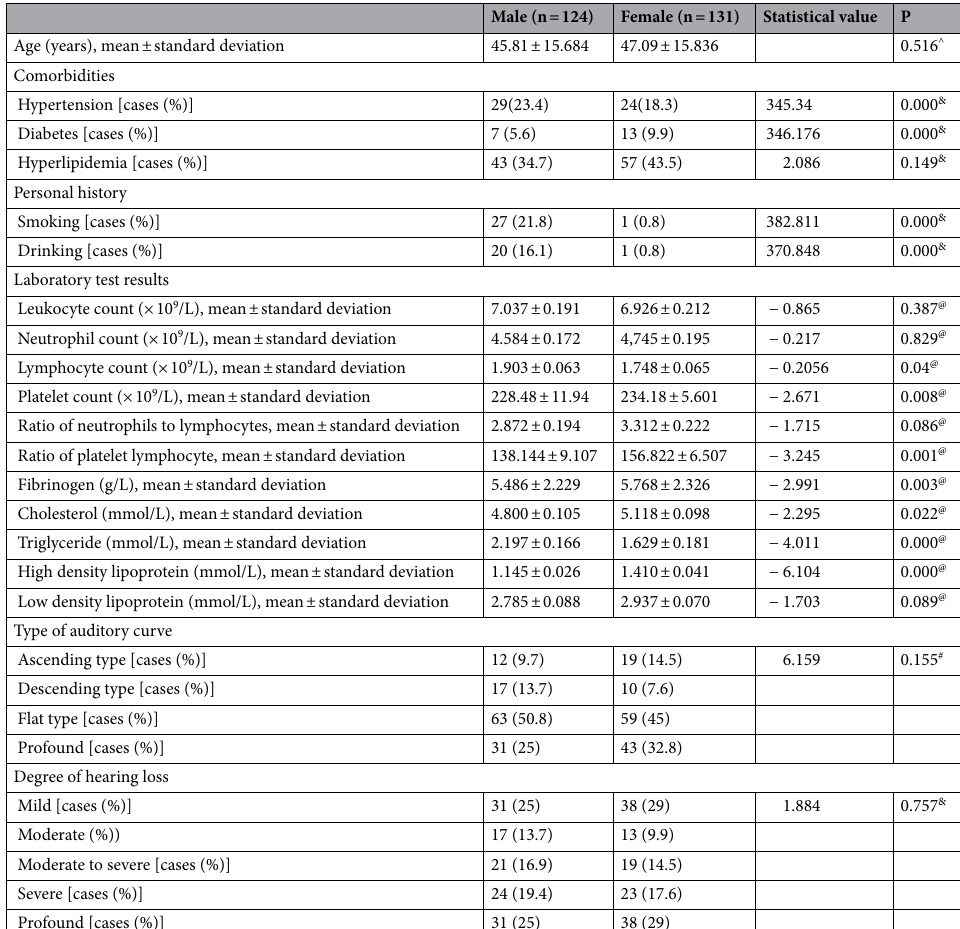
Table 3. Clinical characteristics, comorbidities prevalence, laboratory examination and hearing results of male and female SSNHL patients. ^ T test, & The Chi-squared test, @ nonparametric Mann Whitney U test, # Fisher’s